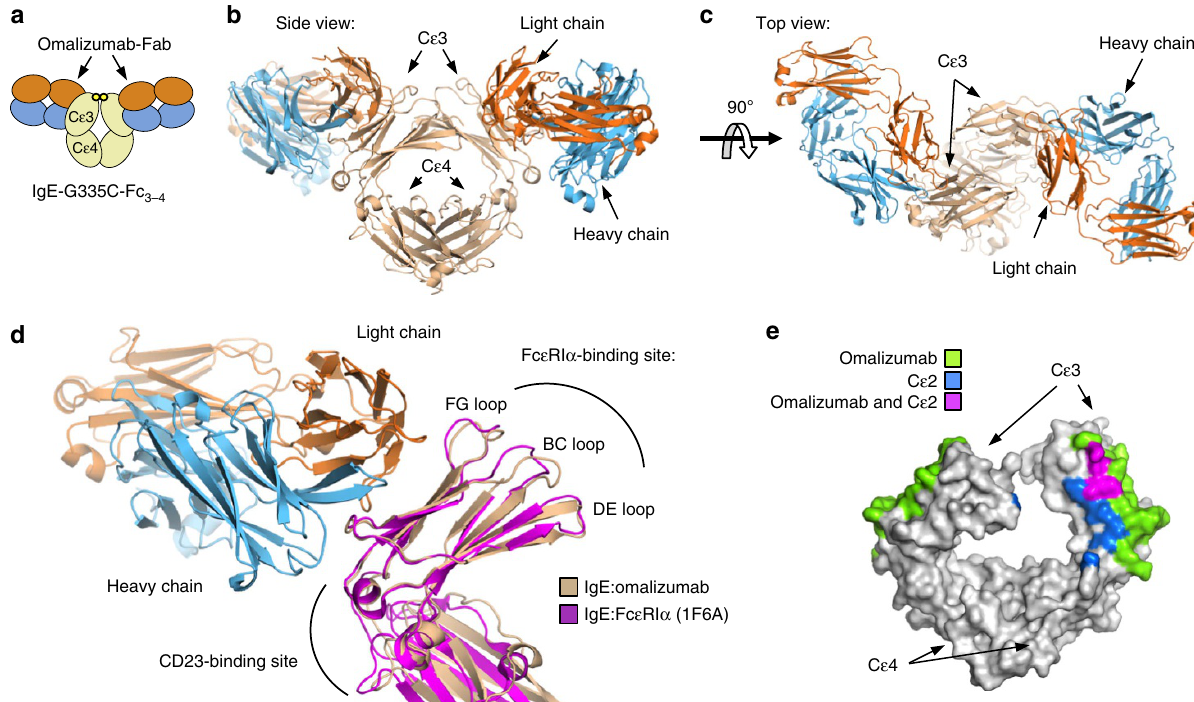
Figure 2 | The IgE:omalizumab complex. An overview of the IgE:omalizumab complex. Blue, omalizumab heavy chain; orange, omalizumab light chain; and tan, IgE-G335C-Fc. ( a ) A cartoon diagram of the biological unit, showing IgE-G335C-Fc 3–4 and two omalizumab Fabs binding symmetric sites. ( b ) The side view of the biologic unit of the IgE:omalizumab complex shows the omalizumab–Fab approaching perpendicularly relative to the C e 3–C e 4 domains. ( c ) The top view of the complex reveals the two nonoverlapping and symmetric omalizumab epitopes on each C e 3 domain within the IgE. ( d ) Comparison of IgE:omalizumab, Fc e RI a (1F6A) and CD23 (4EZM) complexes demonstrates that omalizumab binds between CD23 and Fc e RI a -binding sites within the IgE–C e 3 domain. Alignment of the IgE:omalizumab complex with the C e 3 domain of the IgE:Fc e RI a complex, in magenta, reveals no major perturbations in the Fc e RI a -binding loops. ( e ) Omalizumab and C e 2 directly compete for IgE-binding sites of the surface of